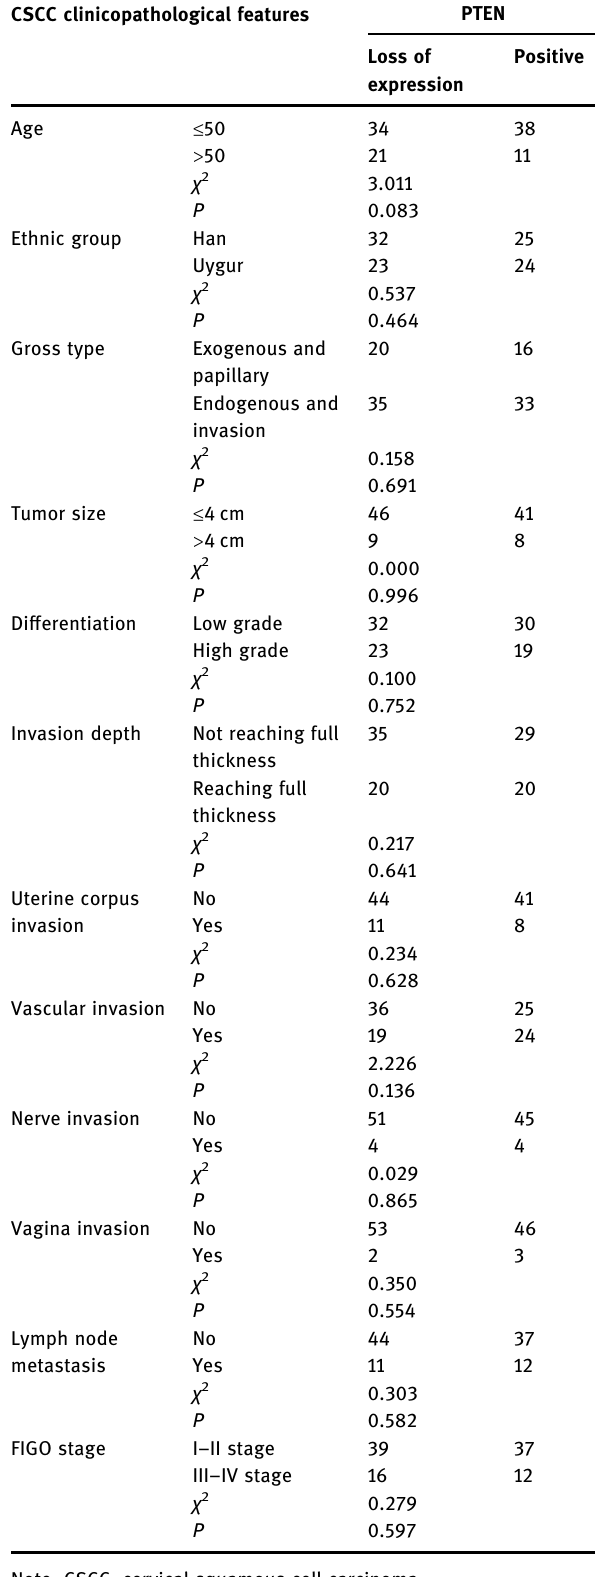
PTENCSCC clinicopathological